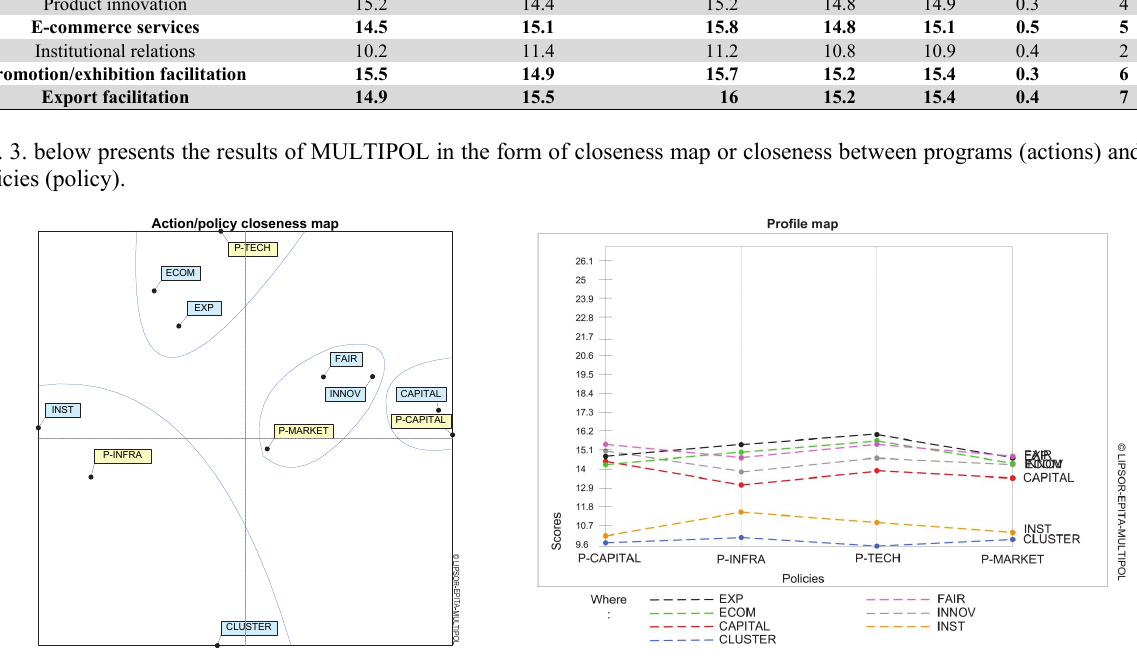
Fig. 3 Linkages between Policy and Action (Closeness Map) Fig. 4. Profile Map of SMEs Developing